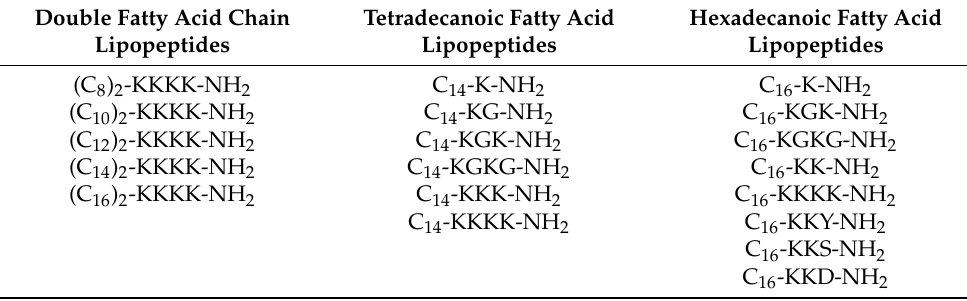
Table 2. Amino acid sequences of the studied antimicrobial lipopeptides. Double Fatty Acid Chain